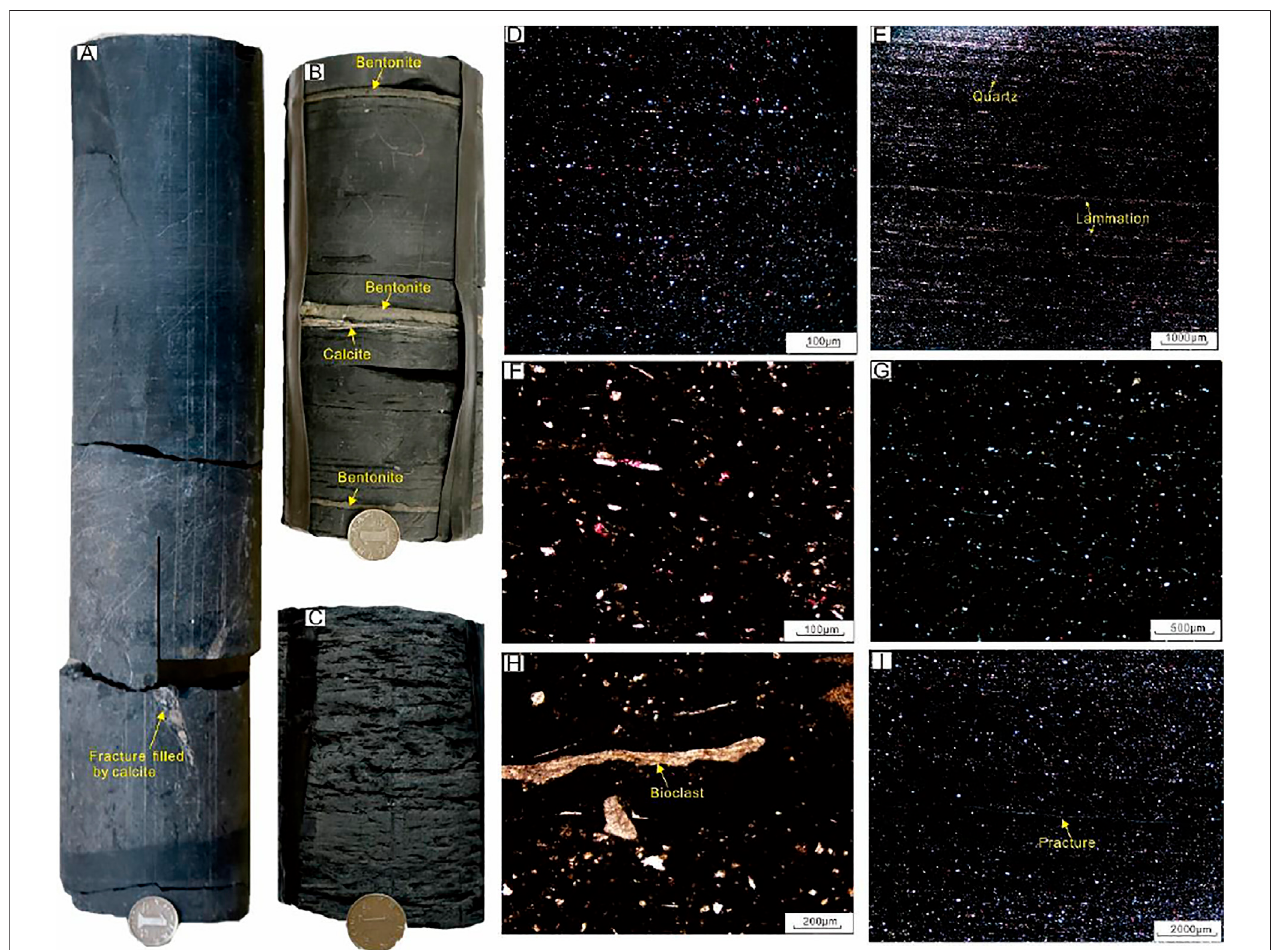
FIGURE 4 | Lithofacies types and characteristics of organic-rich shale in the Longmaxi Formation, Changning area. (A) Carbonate-rich siliceous shale (S-3), core photograph showing fractures fi lled by calcite, 2,232.78 – 2,232.24 m, well N10. (B) Carbonate/siliceous shale (M-1), core photograph showing bentonite and calcite lamination,2,354.70 – 2,354.93m,wellN11. (C) Mixedshale(M-2),massivestructure,2,523.54 – 2,523.67m,wellN1. (D) Mixedsiliceousshale(S-2),quartz,andcalcite particles can be found in the thin section, 2,500.41 m, well N15. (E) Clay-rich siliceous shale (S-4), thin-section photo showing abundant parallel lamination, 2,508.68 m, well N15. (F) Clay-rich siliceous shale (S-4), thin-section photo showing quartz particles evenly distributed and micrite dolomite and calcite sporadically distributed, 2,493.98 m, well N15. (G) Argillaceous/siliceous shale (M-4), 2,486.5 m, well N15. (H) Carbonate/siliceous shale (M-1); bioclasts can be found in the thin section, 2,512.22 m, well N15. (I) Mixed shale (M-2) with microfractures found in the thin section, 2,491.59 m, well N15. Note that the diameter of the coin is 2.5 cm.